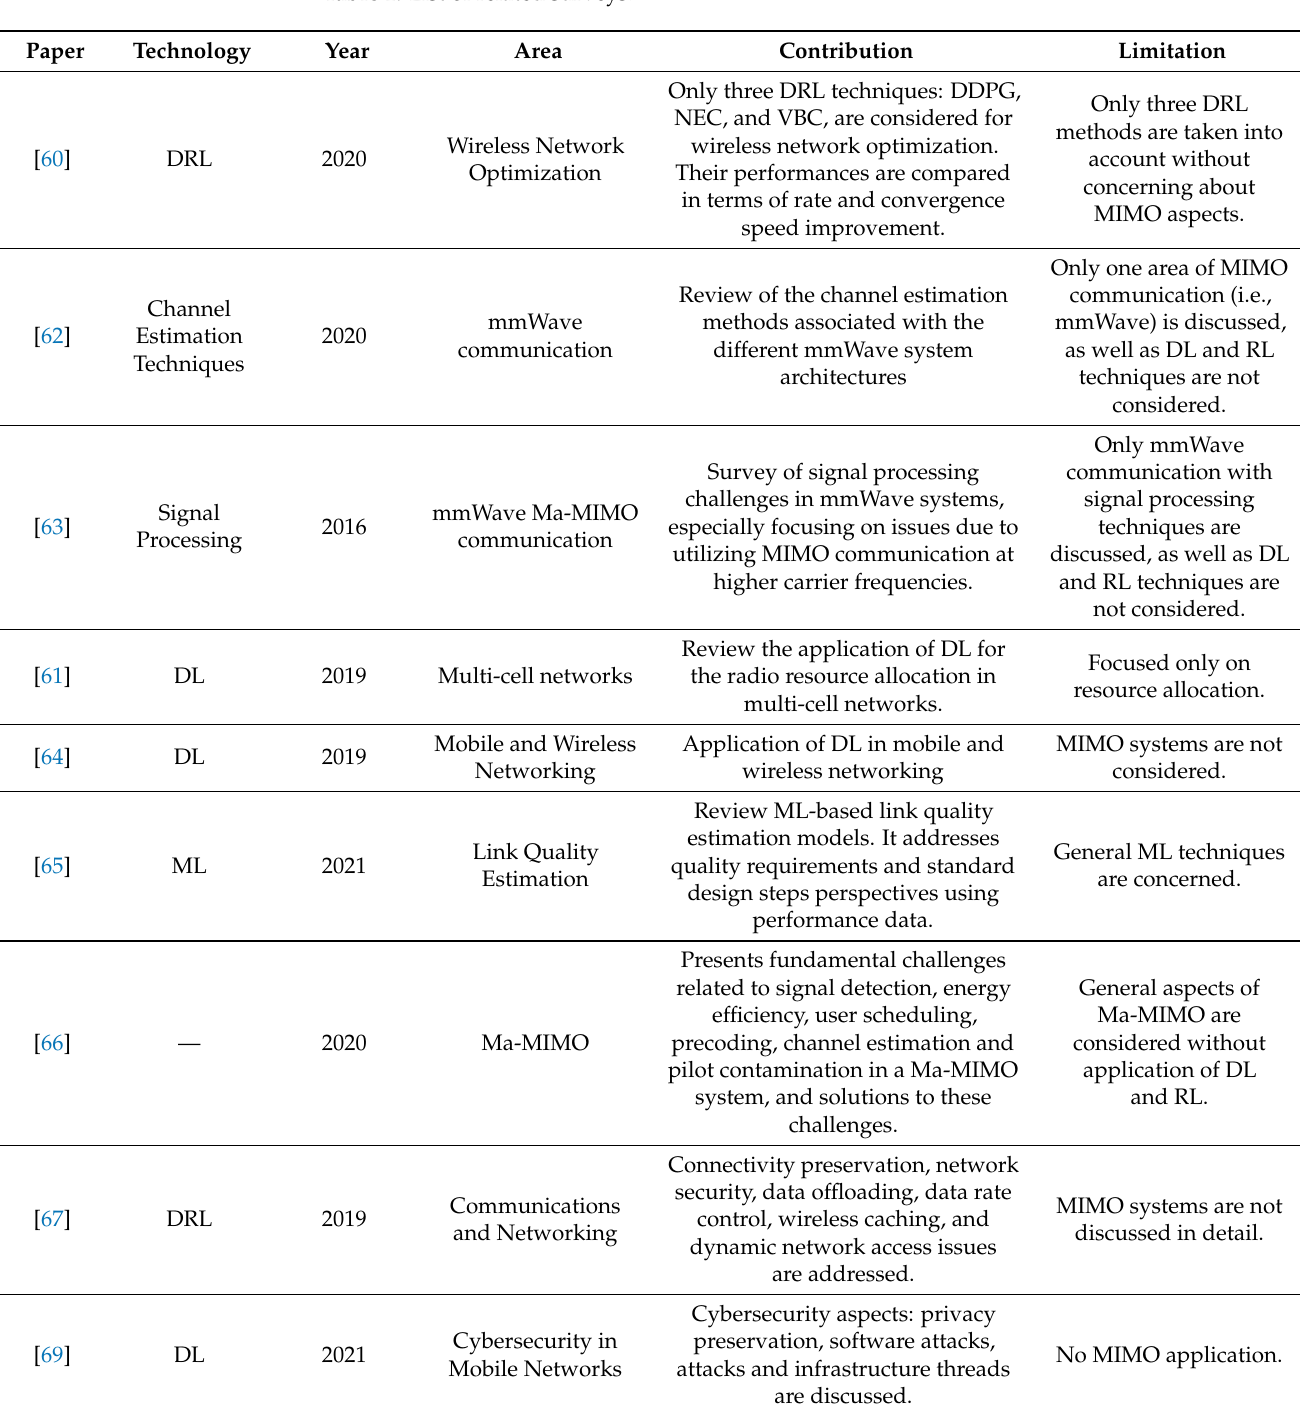
Table 1. List of related